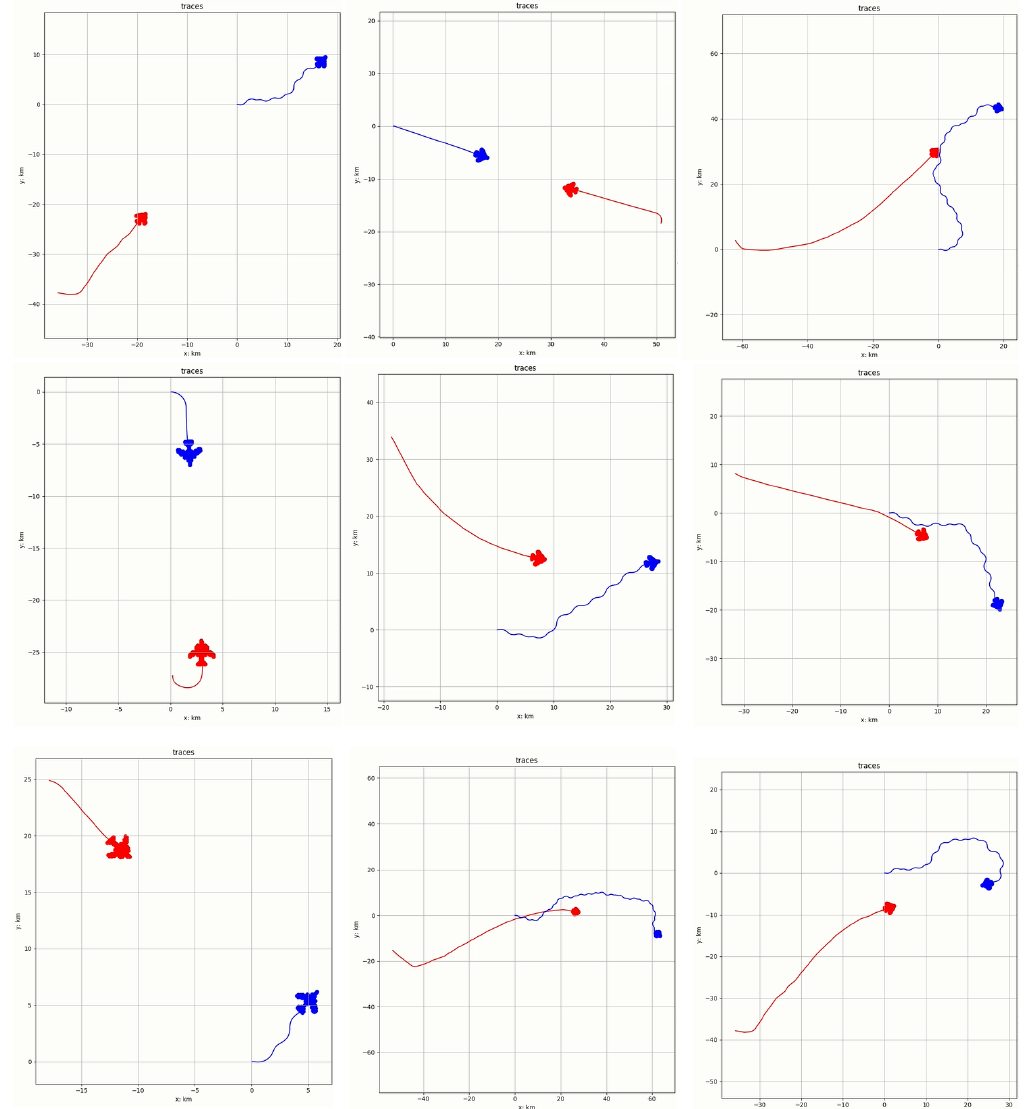
Figure 15. Other cases of 2D air